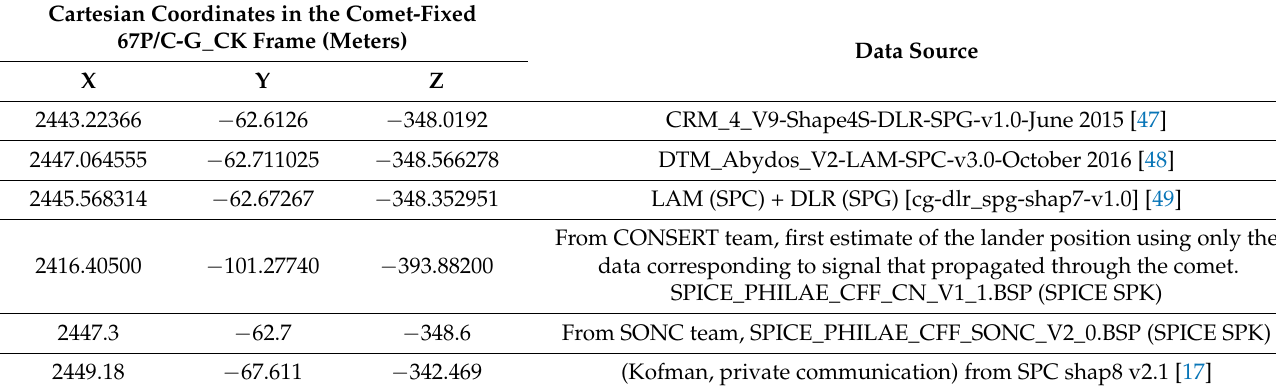
Table 3. Philae lander position from different